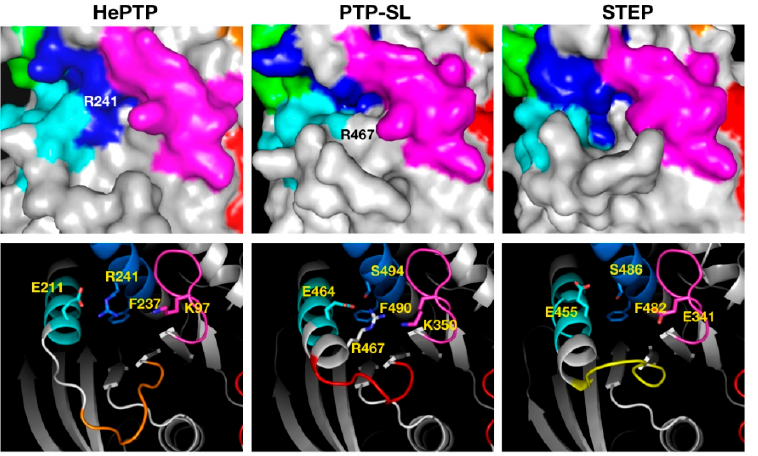
Figure 4. Structural analysis of the pocket associated with cluster 5 across the three KIM-PTPs (HePTP, PTPSL and STEP). In the top panels the three KIM-PTPs are represented as surfaces, whilst in the bottom panels they are shown in cartoon format, with key residues shown as sticks and labelled accordingly. In both panels the colouring is as follows: KIM-PTP specific motifs K5 (magenta), K6 (cyan), and K7 (blue). In the bottom panel the difference in the conformation of the loop that forms the lip at the bottom entrance of the pocket is also coloured as follows: HePTP (orange), PTPSL (red), and STEP (yellow) to aid visualisation.